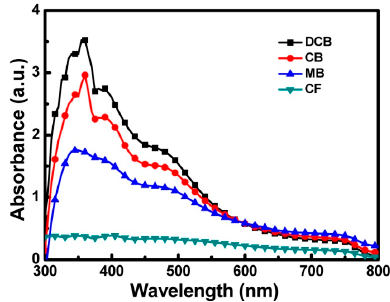
Figure 9. The absorption spectra of the perovskite active layers based on various ETL solvents.